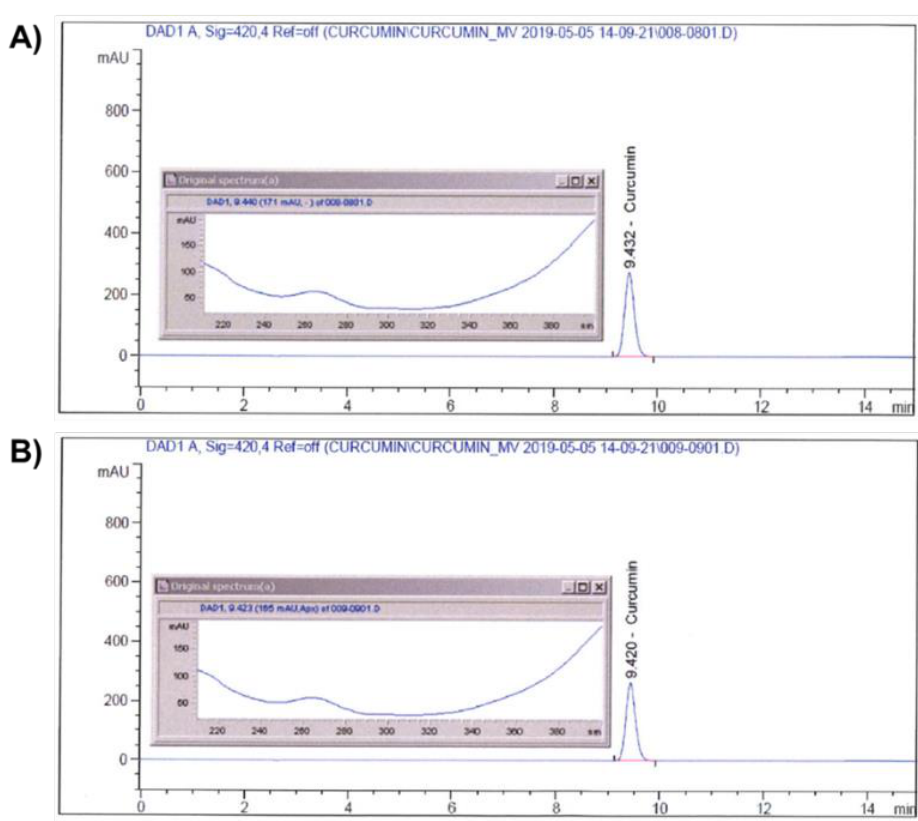
Figure 1. Identification of curcumin on standard ( A ) and CM-SD ( B ) by HPLC.